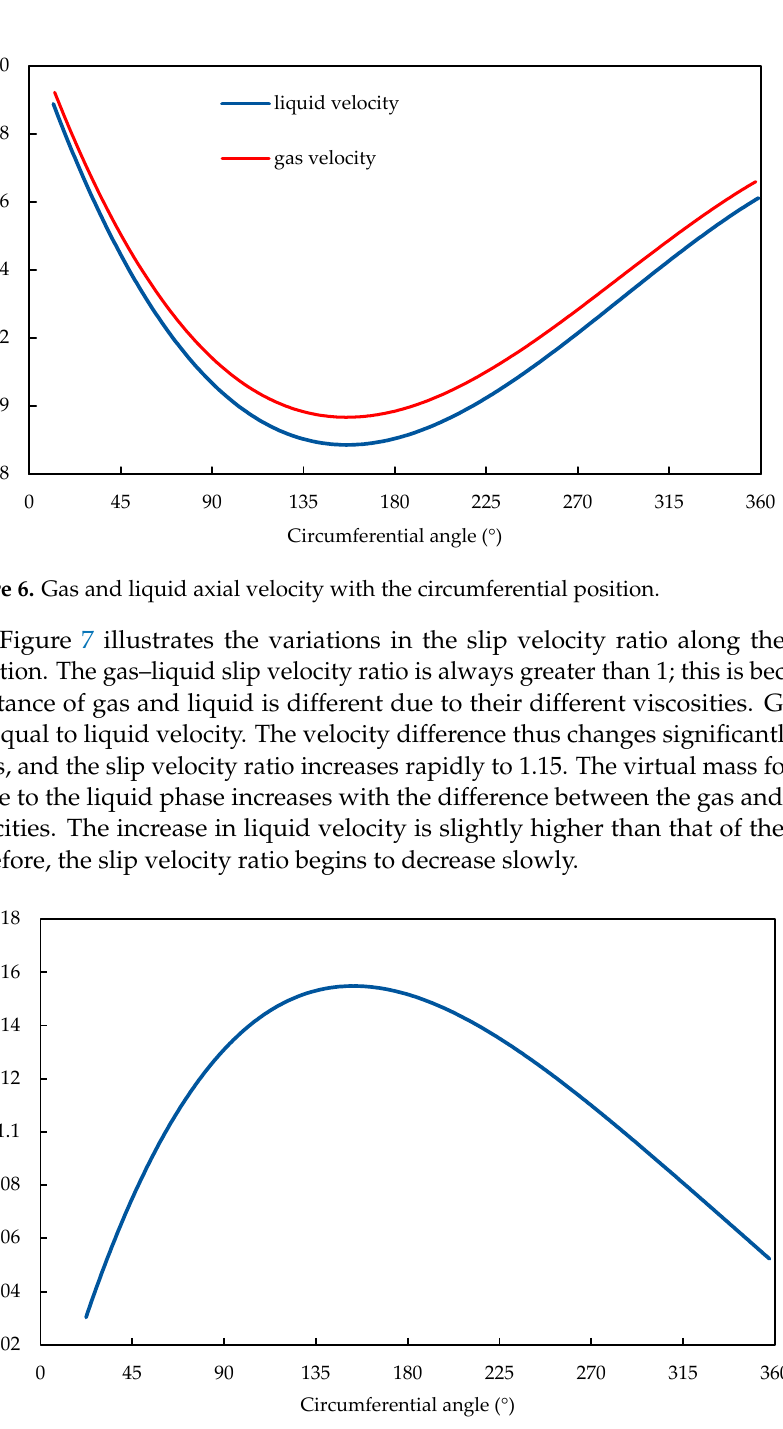
Figure 8. Profile of CT cross-sections. The contour plots of liquid velocity at different cross-sections of spiral tubing are shown in Figure 9. The velocity has a D-shaped step distribution; the liquid velocity near the tube inside is the lowest, with the highest velocity occurring near the outside of the tube. The liquid phase velocity distribution on the upper and lower sides is nearly sym- metrical. The red area in the figure means that the maximum velocity zone is off-center and is closer to the outside of the tube, which is induced by the centrifugal forces in the flow. We can see from the contour of 45° cross-section A that the velocity core area is small, and the degree of inward depression is also tiny. As the fluid flows, the velocity of the fluid in the spiral tubes is enhanced by centrifugal forces. Moreover, it can be seen that